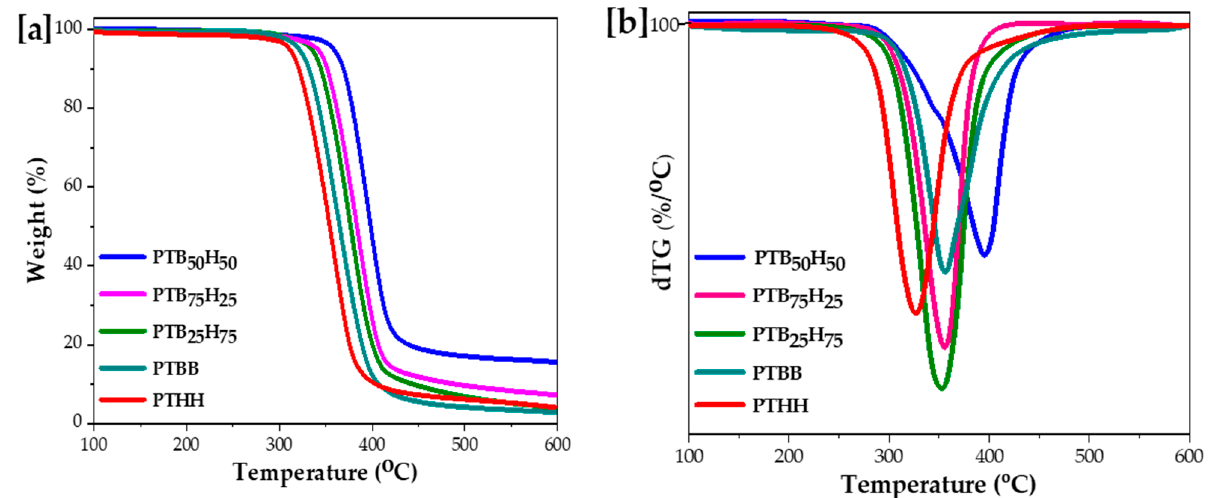
Figure 5. ([ a ] TGA and [ b ] dTG of poly(1,4-bis(2-hydroxyethyl)benzene thiophenedicarboxylate) (PTBB), poly(hexylene thiophenedicarboxylate) (PTHH), and poly(hexylene 2,5- thiophenedicarboxylate-co-bis(2-hydroxyethoxybenzene) copolyesters.